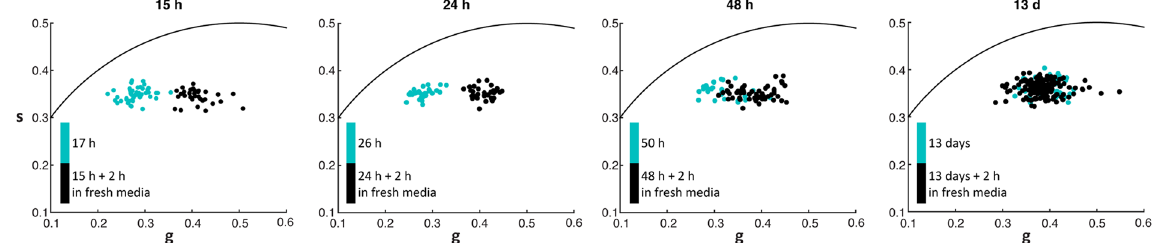
Figure 5. Bacterial phasor recovery after late stationary phase growth. Bacterial phasor of E. coli cells from 15 h, 24 h, 48 h and 13 d cultures recovered for an additional 2 h in spent medium from the same culture (cyan) or fresh growth medium